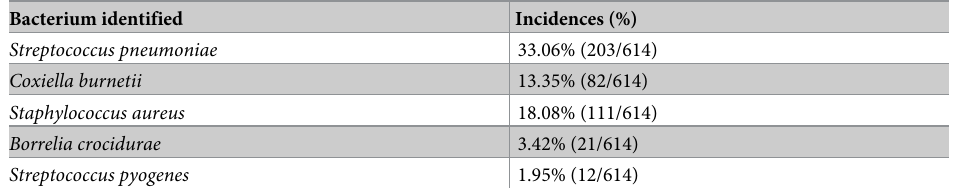
Table 2. Results of prevalence of pathogenic bacteria in Dielmo and Ndiop.